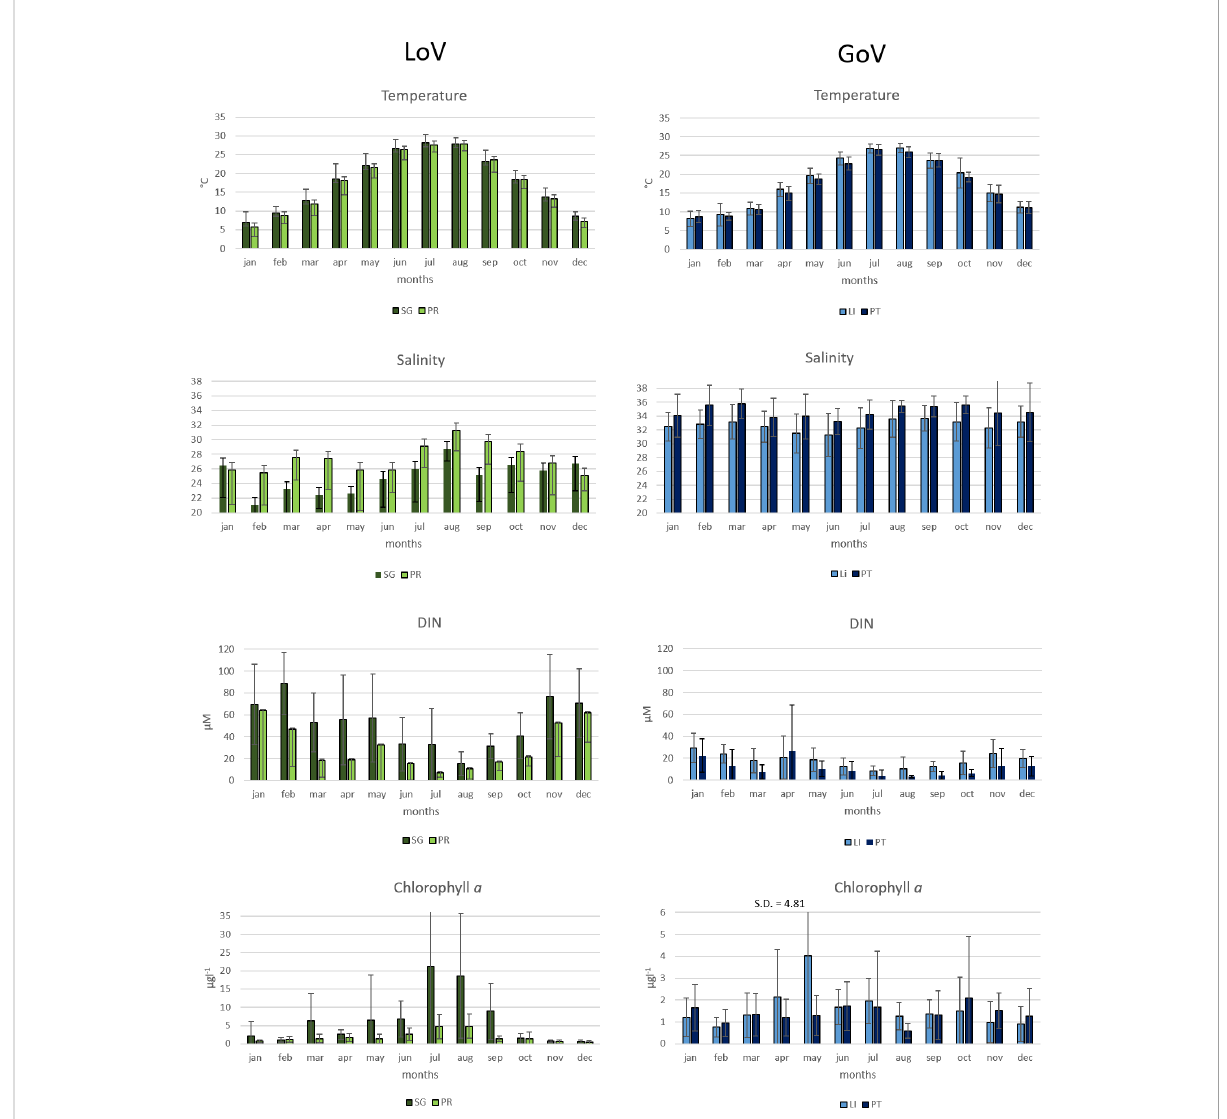
FIGURE 4 Monthly averages (boxes) and standard deviations (whiskers) of selected abiotic parameters: temperature, salinity, DIN (Dissolved Inorganic Nitrogen) and chlorophyll a at the four stations in the LoV (St. SG and St. PR; left) and GoV (St. LI and St. PT; right). SG, San Giuliano station; PR, Palude della Rosa station; LI, Lido station; PT, Platform